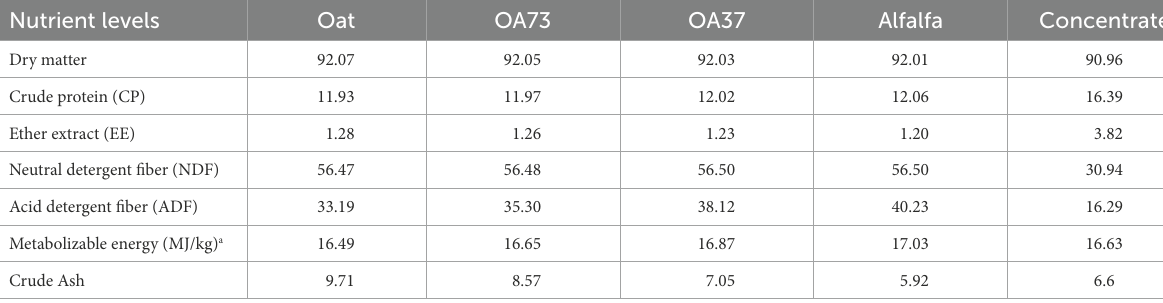
TABLE 1 Composition and nutrient levels of diets (dry matter basis,